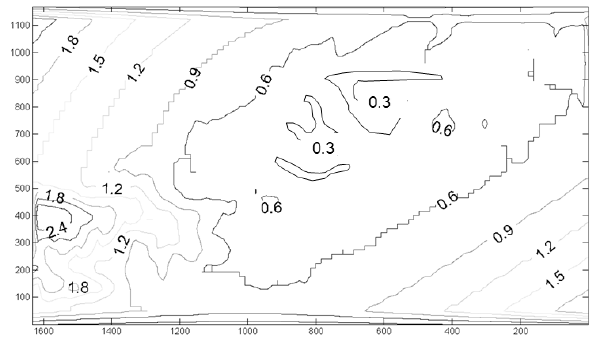
Figure 5. Accuracy at FCPs with bias compensation for 1st degree RFM (range: ± 0.3-2.7